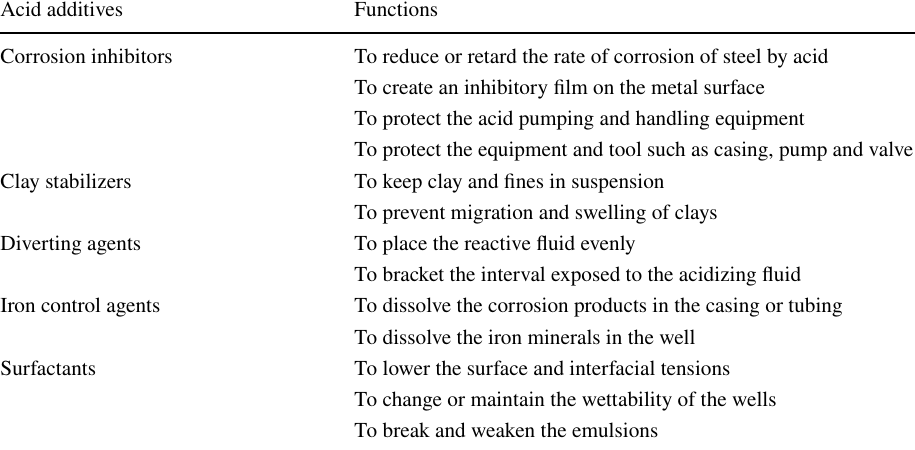
Table 5 Summary of the additives used in matrix acidizing and their